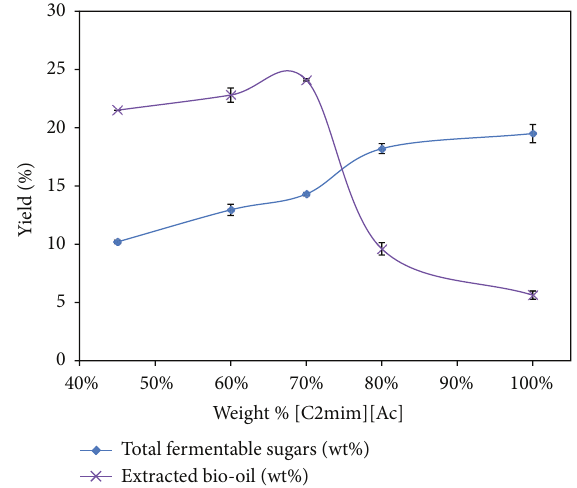
Figure 3: Total fermentable sugars and bio-oil yields relative to weight of whole seed obtained from pretreated jatropha whole seed (kernel plus shell) at different concentrations of [C2mim][Ac].